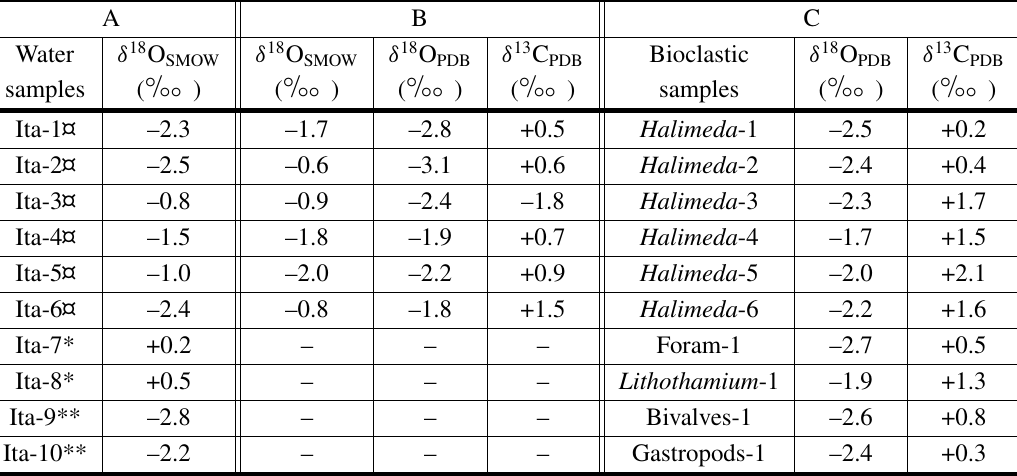
δ 13 C and δ 18 O values for beachrocks at Jaguaribe beach in Itamaracá Island (A) seawater, freshwater and interstitial water (B) dissolved carbonate in the interstitial water; (C) primary